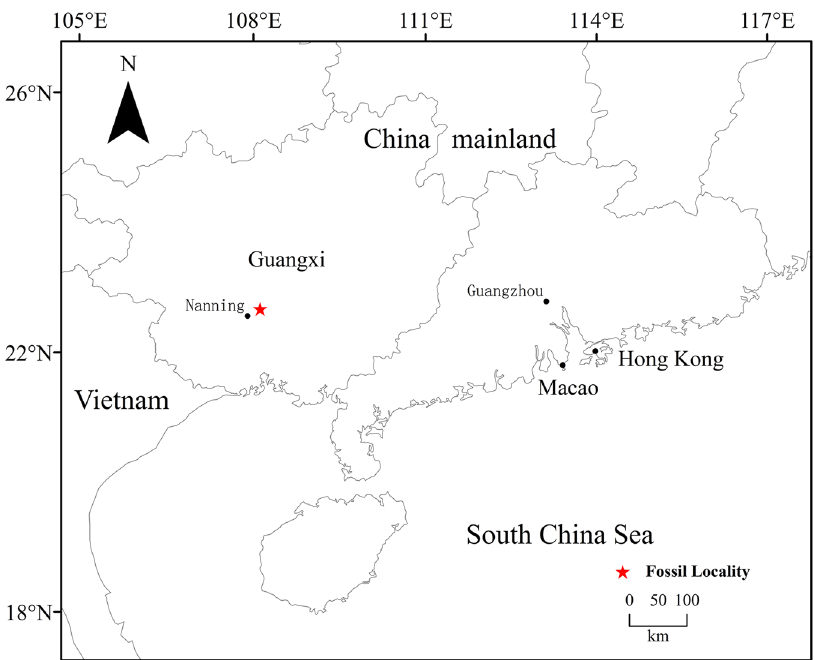
Results Systematics Class Magnoliopsida Brongn. Order Ericales Bercht. & J. Presl. Family Theaceae Mirbel.